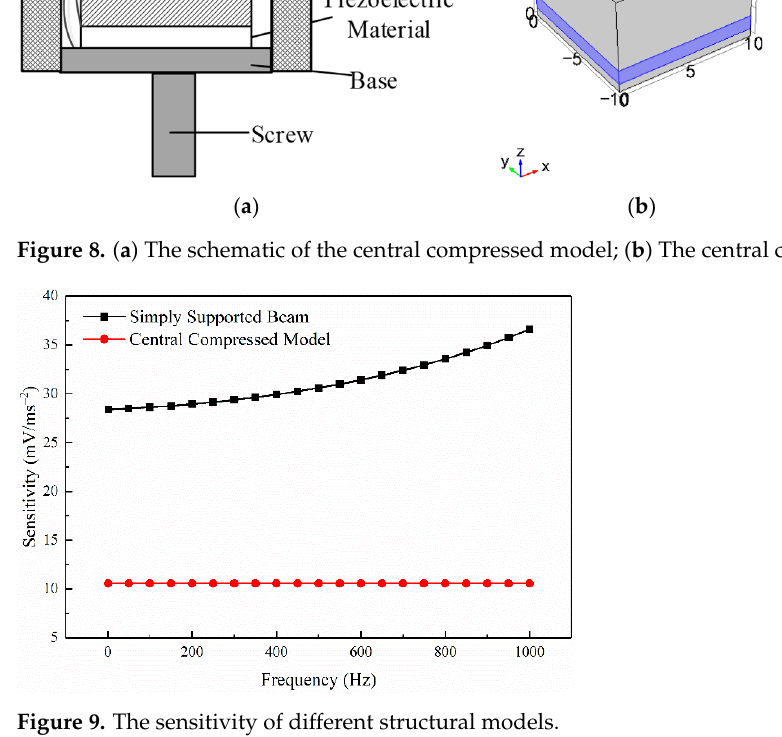
Figure 9. The sensitivity of different structural models.